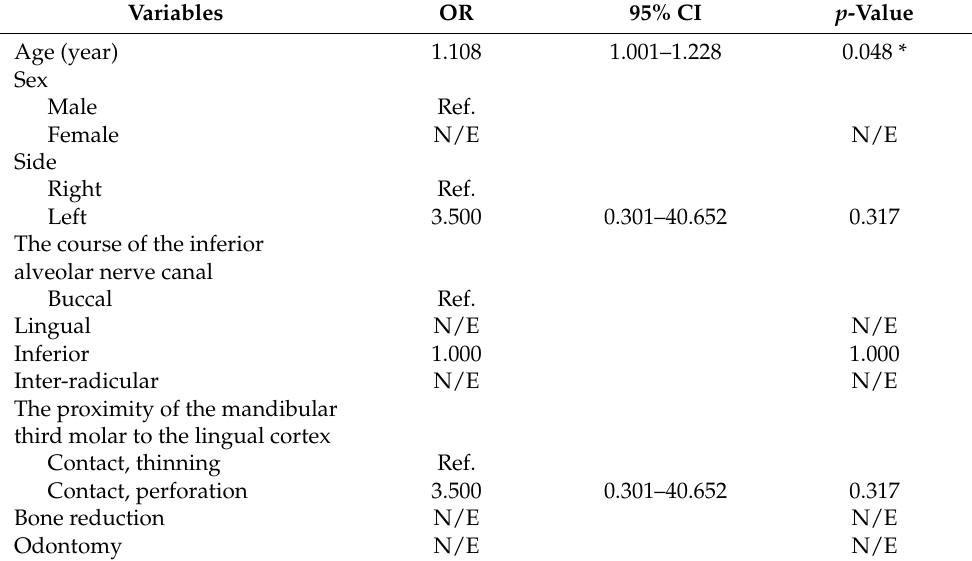
Table 3. Univariate Logistic Regression of the Occurrence of Inferior Alveolar Nerve Injury versus Demographic and Procedural Variables in Exposed Group.